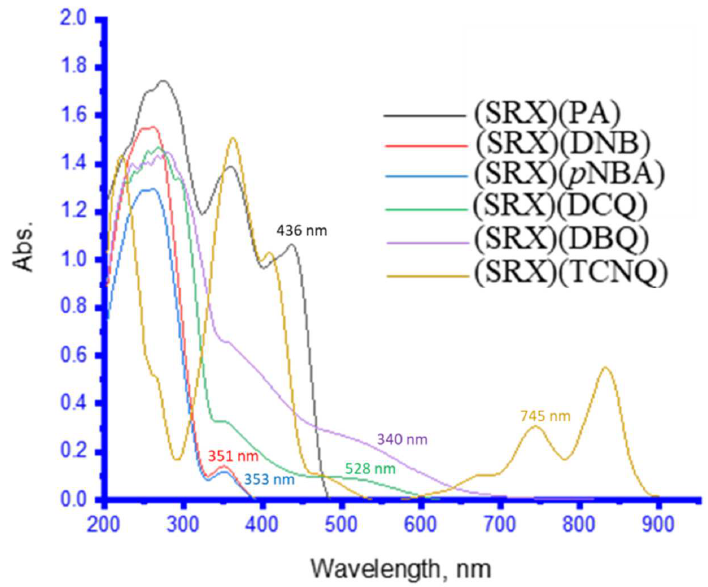
Figure 5. UV–Vis spectra curves of the SRX with the six π–acceptors complex [4].